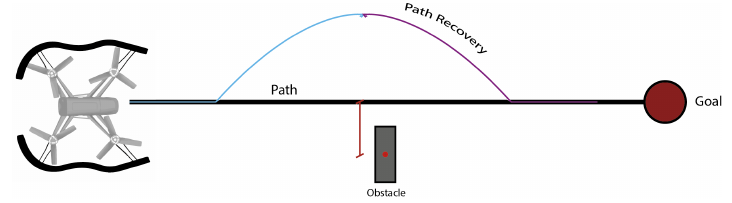
Figure 14. Path recovery of one